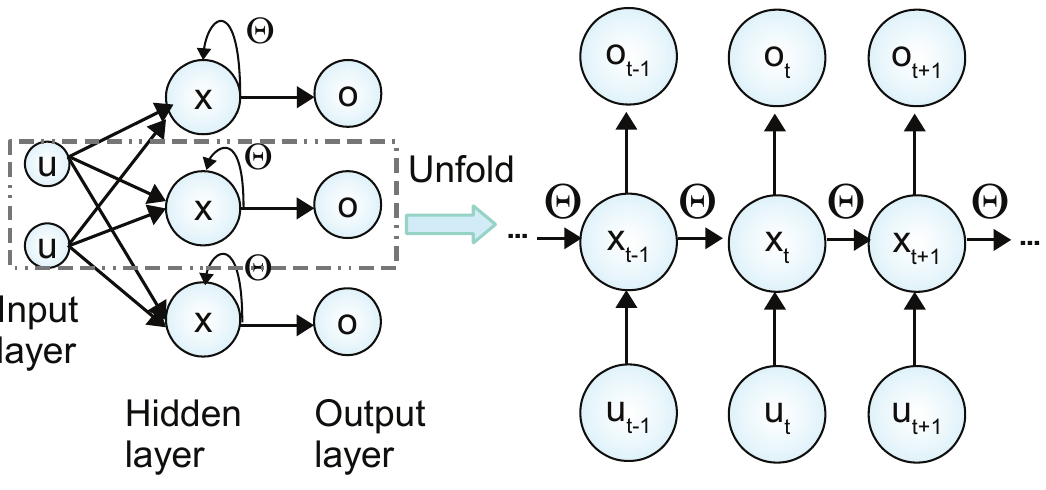
Figure 1. A recurrent neural network and its unfolded structure, where Θ is the weight matrix, x is the state vector, u is the manipulated input vector and o is the output